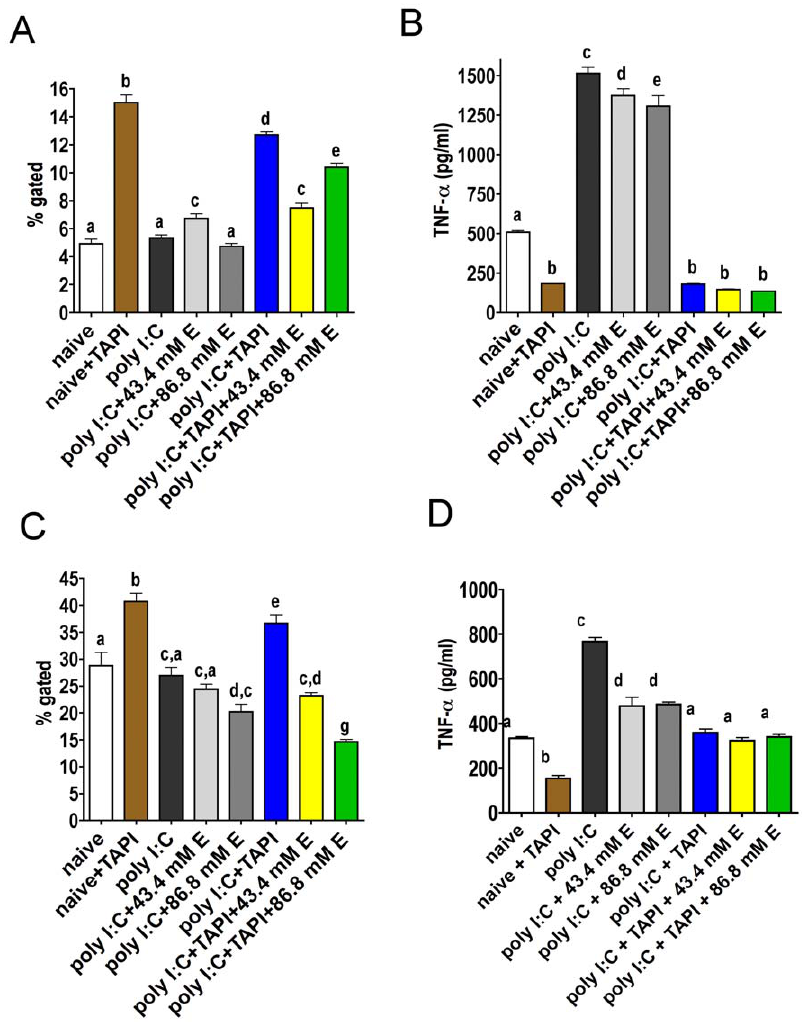
Figure 6. Surface expression of TNF- a in RAW264.7 cells measured by flow cytometry, and TNF- a ELISA from cell culture supernatants of the same experiments. Results shown in A and B were from one experiment and results shown in C and D are from an independent experiment. Each group contained 5 samples. Cells were treated with ethanol (either 43.4 mM or 86.8 mM, as indicated in the Figure), 50 m g/ml poly I:C, 20 m g/ml TAPI-0 (with no DMSO), or a combination of these treatments. ELISA was performed from cell culture supernatants of each group. The percentage of gated cells for each group is shown in A and C . Results for TNF- a ELISA from cell culture supernatants of the cells used for flow cytometry are depicted in B and D . Values for bars designated by the same letter are not significantly different (p . 0.05); values for bars with no shared letters are significantly different (p , 0.05).